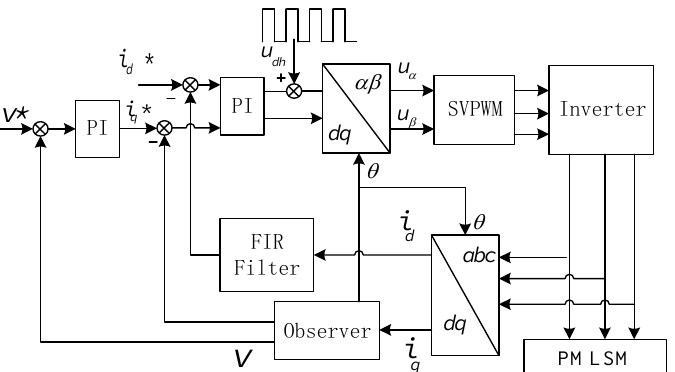
Figure 8. Block diagram of the position-sensorless control system based on high-frequency square-wave voltage injection.